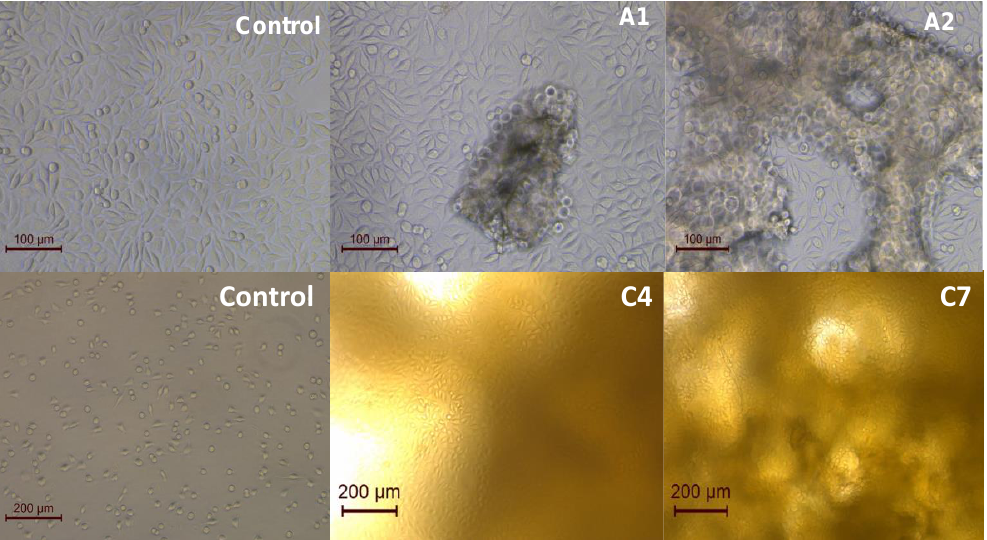
Figure 12. Morphological images of cells in the samples of Control, SF/HA ( A1 , A2 ) at three days and curcumin-loaded SF/HA hydrogels ( C4 , C7 ) at seven days.